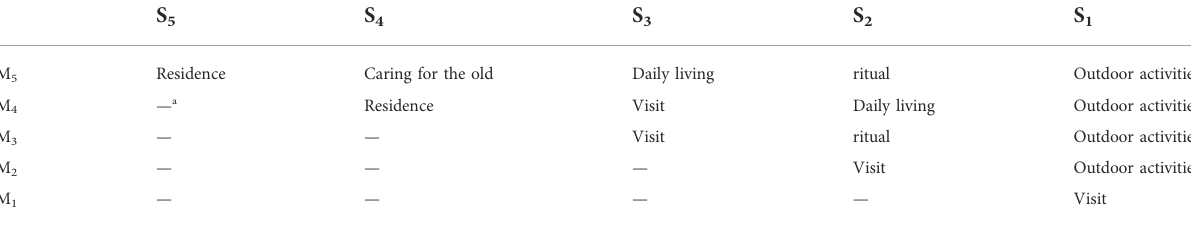
TABLE 1 Traditional activities in every node for different members.